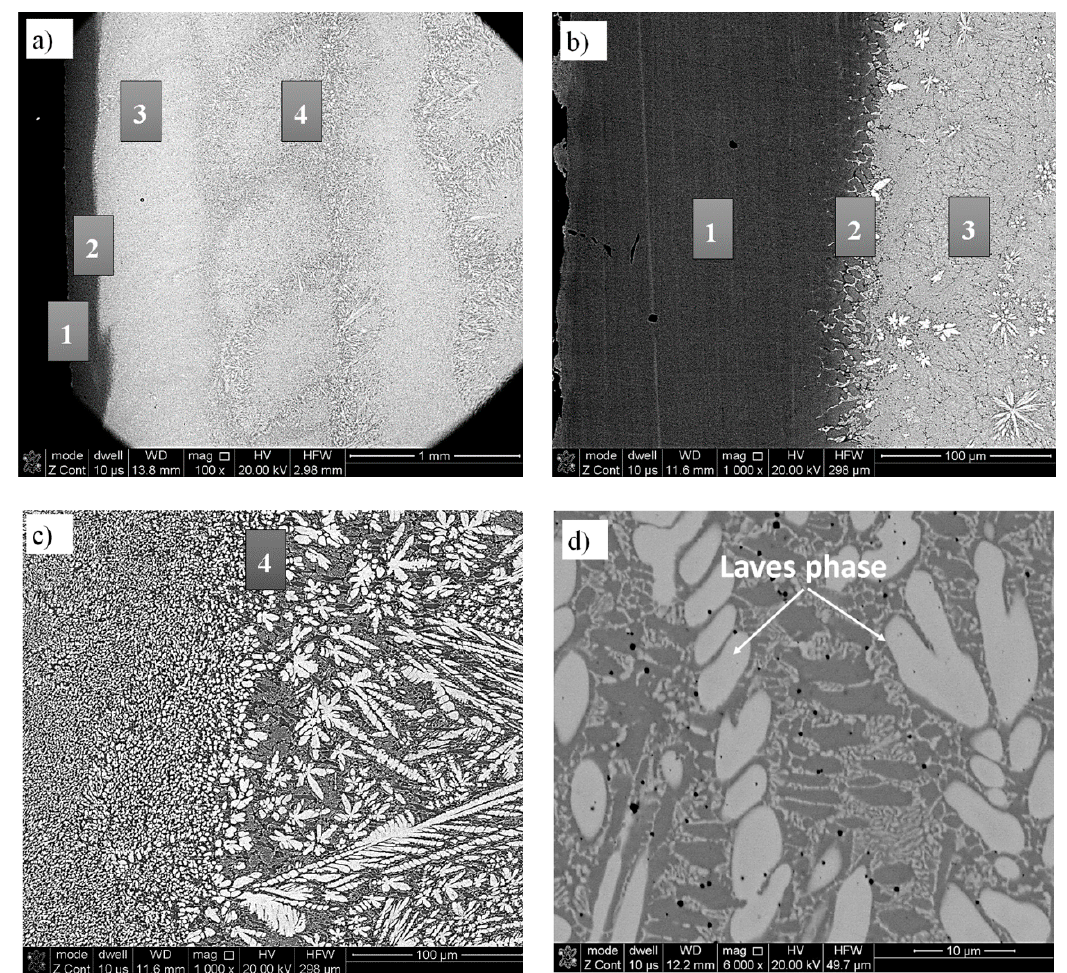
Figure 5. The SEM images of the microstructure of T-800 coating—specimen number 18. Coating/substrate interface ( a , b ) and coatings ( c , d ).